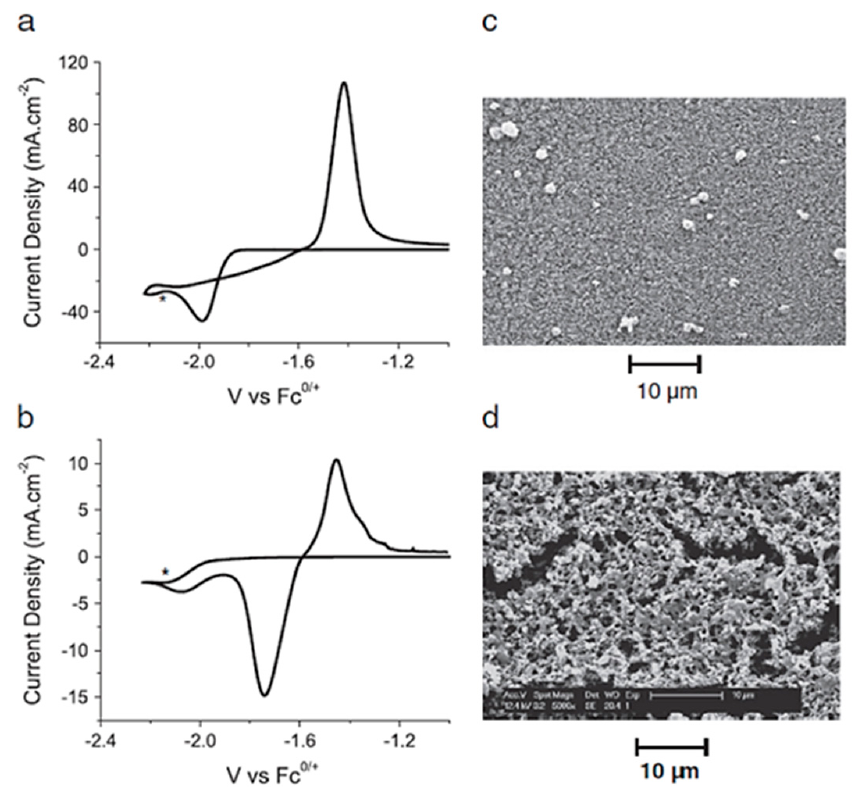
Figure 4. CVs and SEMs of 10 mol% Zn(dca) 2 in [EMIm][DCA] on a GC working electrode held at − 2.15 V vs. Fc 0 /+ (ferrocene / ferrocenium) (marked by *) for 10 min at di ff erent water contents: ( a ) CV of 3 wt% H 2 O, scan rate 100 mV · s − 1 , ( b ) CV of 0.05 wt% H 2 O, scan rate 100 mV · s − 1 , ( c ) SEM of 3 wt% H 2 O, ( d ) SEM of 0.05 wt% H 2 O. [Reproduction with permission from Simons, T.J.; Torriero, A.A.J.; Howlett, P.C.; MacFarlane, D.R.; Forsyth, M., Electrochem. Commun.; published by Elsevier, 2012].